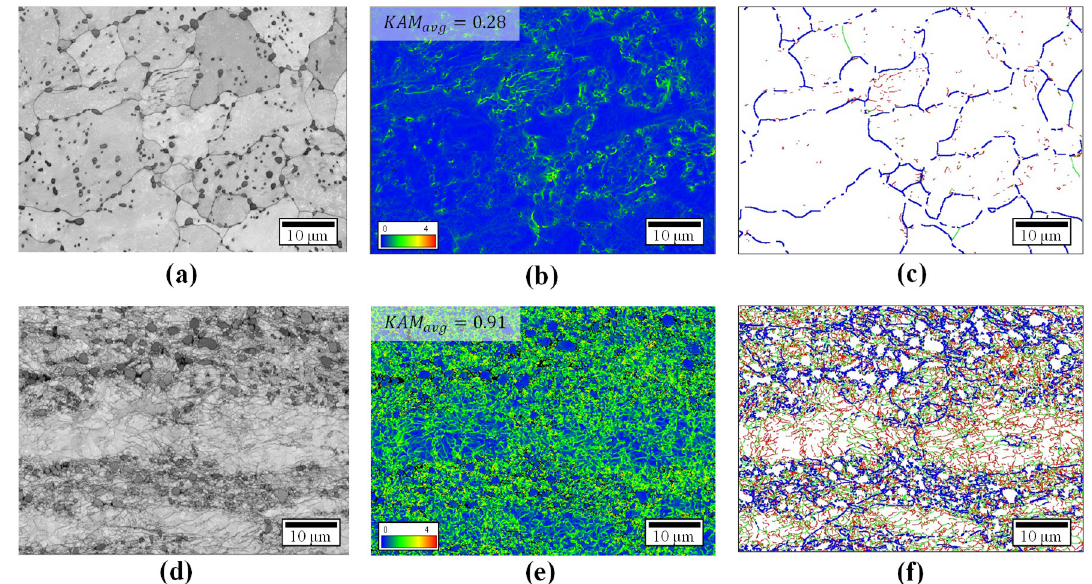
Figure 12. Comparison of band contrast map ( a , d ), KAM map ( b , e ), and GB map ( c , f ) of LAGBs (2 ◦ ≤ θ < 5 ◦ , red lines and 5 ◦ ≤ θ < 15 ◦ , green lines) and HAGBs (15 ◦ ≤ θ , blue lines): ( a – c ) raw material and ( d – f ) forged